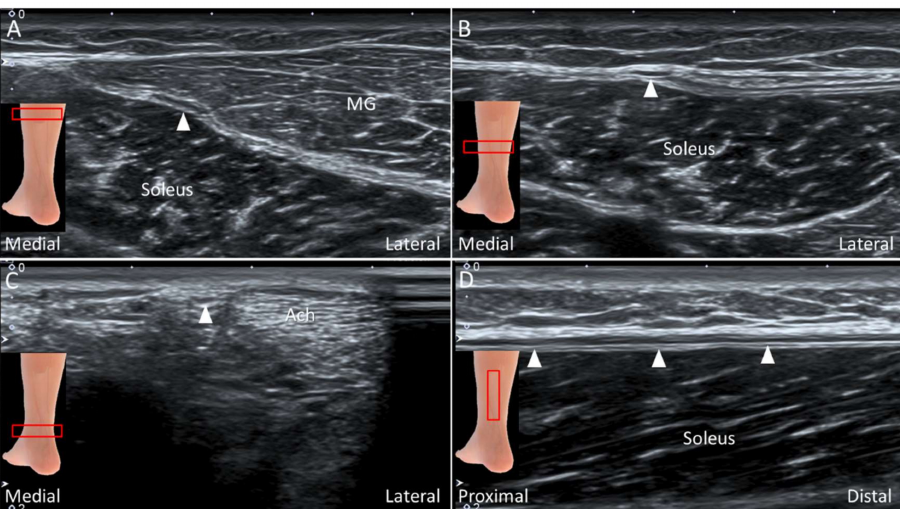
Figure 23. Imaging of the plantaris tendon (arrows) in the short-axis at the plane between medial gastrocnemius (MG) and soleus muscles ( A ), on the surface of soleus muscle adjacent to the MG tendon ( B ), medial to the Achilles tendon (Ach) ( C ) , and in the long-axis on the surface of soleus muscle ( D